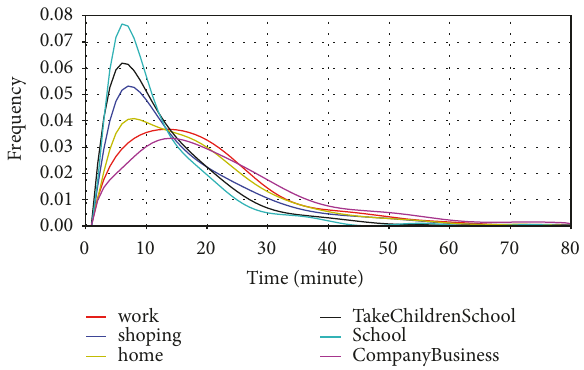
Figure 14: Comparison of car travel time with different